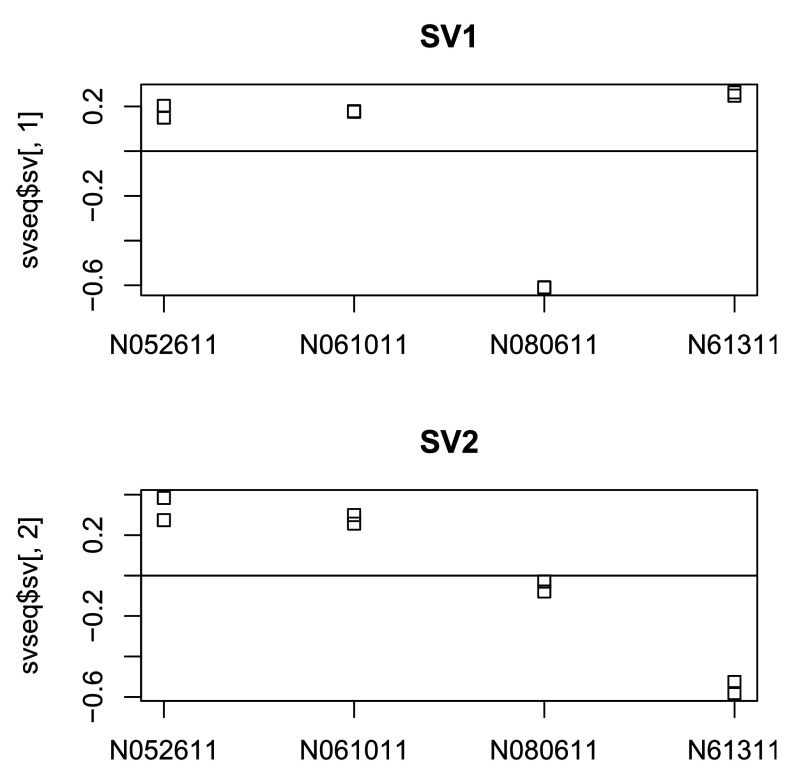
Surrogate variables 1 and 2 plotted over cell line.Here, we know the hidden source of variation (cell line), and therefore can see how the SVA procedure is able to identify sources of variation which are correlated with cell line.